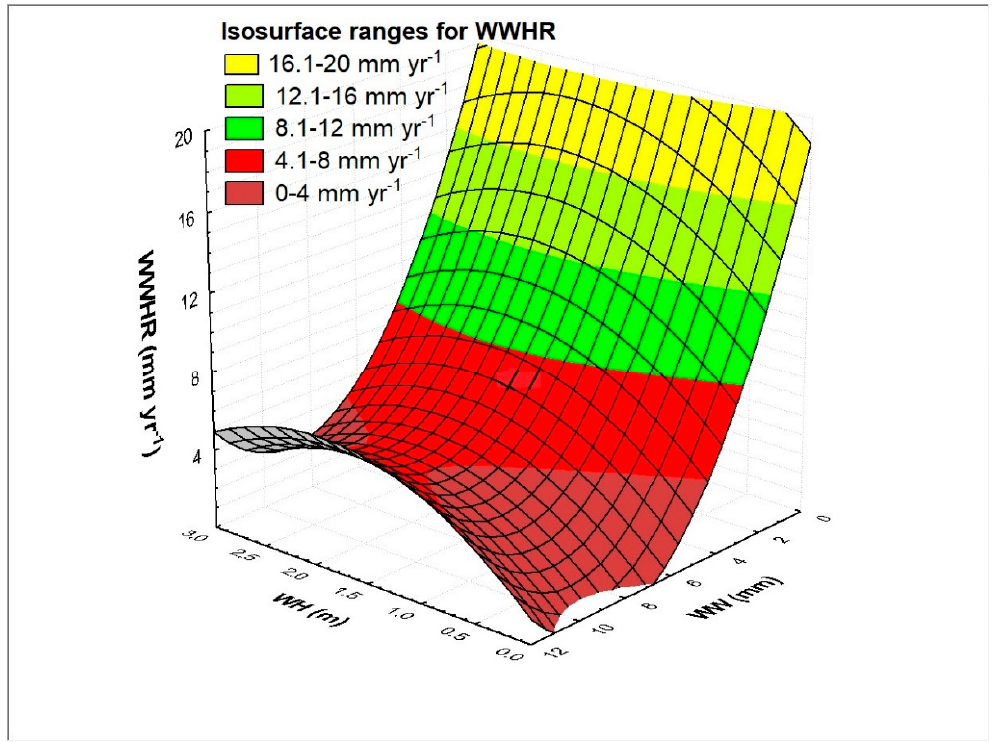
Figure 7. Relationship between wound width healing rate (WWHR), wound height from the ground (WH) and wound width (WW). Non-linear regression R 2adj = 0.570; F(4; 101) = 35.744; p < 0.001; SE = 0.725; WWHR (mm year − 1 ) = 18.785 + 5.517 × WH - 1.433 × WH 2 - 4.481 × WW + 0.252 × WW 2 .